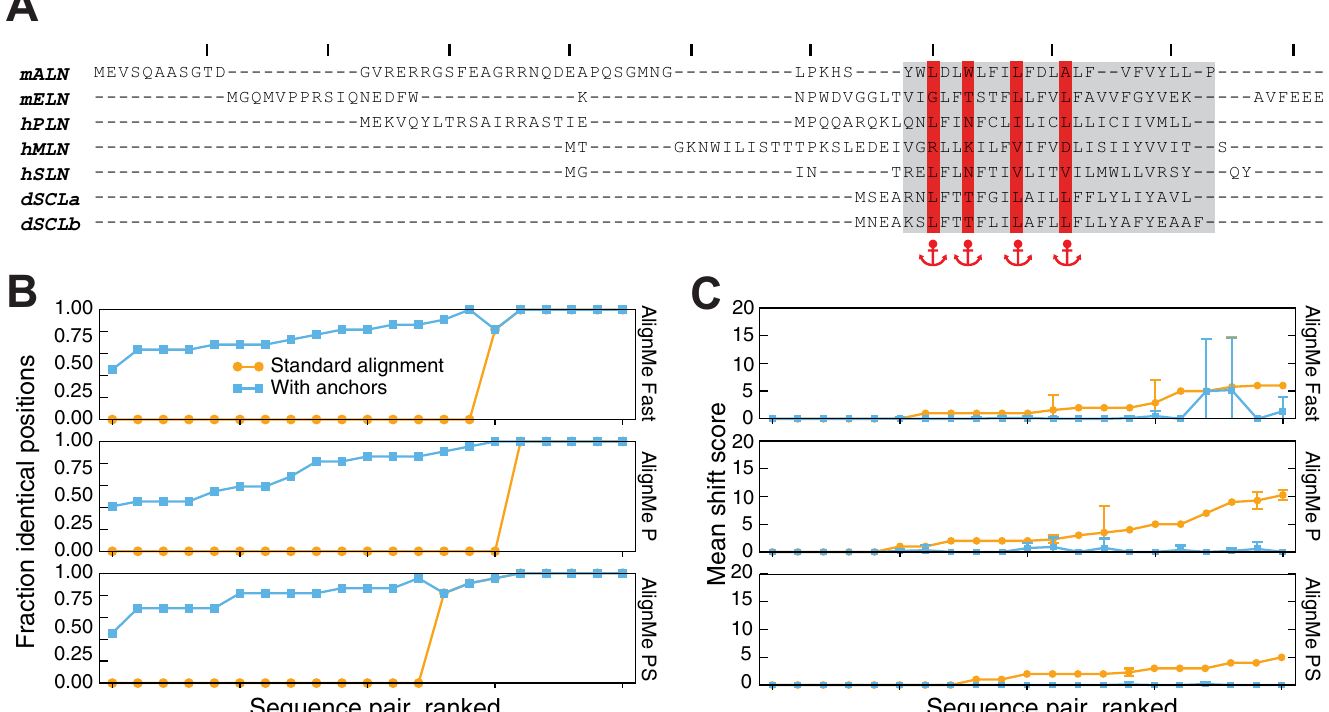
Fig 2. Effect of applying anchors to pairwise alignments of SERCA regulatory subunits using AlignMe. (A) Seven peptides, namely human phospholamban (hPLN), sarcolipin (hSLN), mouse another-regulin (mALN), mouse endoregulin (mELN), human myoregulin (hMLN), and Drosophila sarcolamban a and b isoforms (dSCLa & dSCLb) were pairwise aligned. Anchors were placed at the positions marked in red. In hPLN and hMLN, these residues are known to form contacts with SERCA; their equivalents in the other sequences were proposed previously [38]. Membrane-spanning segment definitions ( gray box ) are highlighted, and tick marks indicate every 10 positions along the alignment. (B, C) The effect of the anchors was assessed for pairwise alignments obtained either without ( orange circles ) or with ( cyan squares ) anchor constraints. The similarity of the AlignMe alignments to those proposed by Primeau et al [38], in the transmembrane region only, was measured as (B) the fraction of positions that are aligned identically, and (C) the extent of the shift discrepancy, or the number of positions by which each aligned column is shifted, relative to the position in the published alignment. The shift is measured as the mean over all residues in the transmembrane segments. Anchors were imposed at four positions in the transmembrane segment ( red in A ). Alignments were obtained using three different AlignMe modes: Fast mode ( upper ), which considers hydrophobicity and a standard substitution matrix; AlignMe P ( middle ), which considers a position-specific substitution matrix obtained from PSI-BLAST; and AlignMe PS ( lower ), which considers the PSSM as well as secondary structure predictions from PSIPRED. Pairs of sequences are sorted according to their accuracy obtained without anchoring. Error bars indicate standard